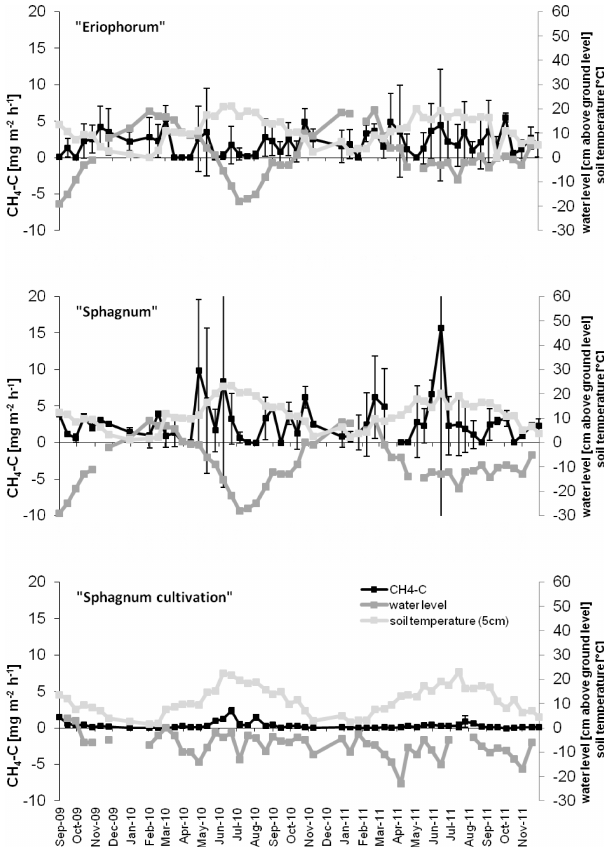
Figure 3. Yearly development of daily R eco , GPP and NEE of the measurement sites (left axis). Soil temperature and PAR of the mea- surement sites (right axis of the upper and middle diagram, respec- tively).